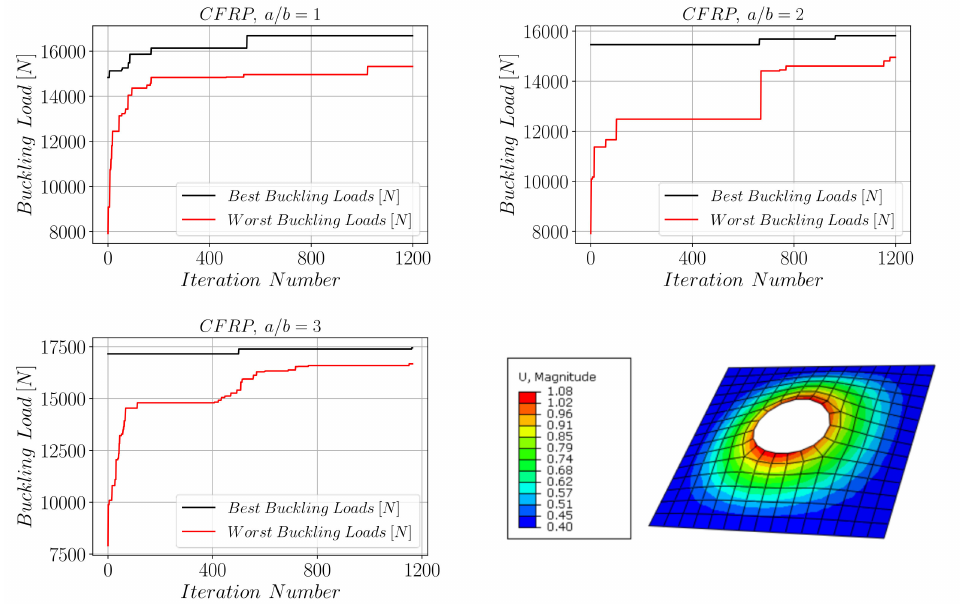
Figure 10. The development of the best and worst-performing stacking sequences in the harmony search optimization for all aspect ratios with circular cut-outs under uniaxial compression parallel to the longer